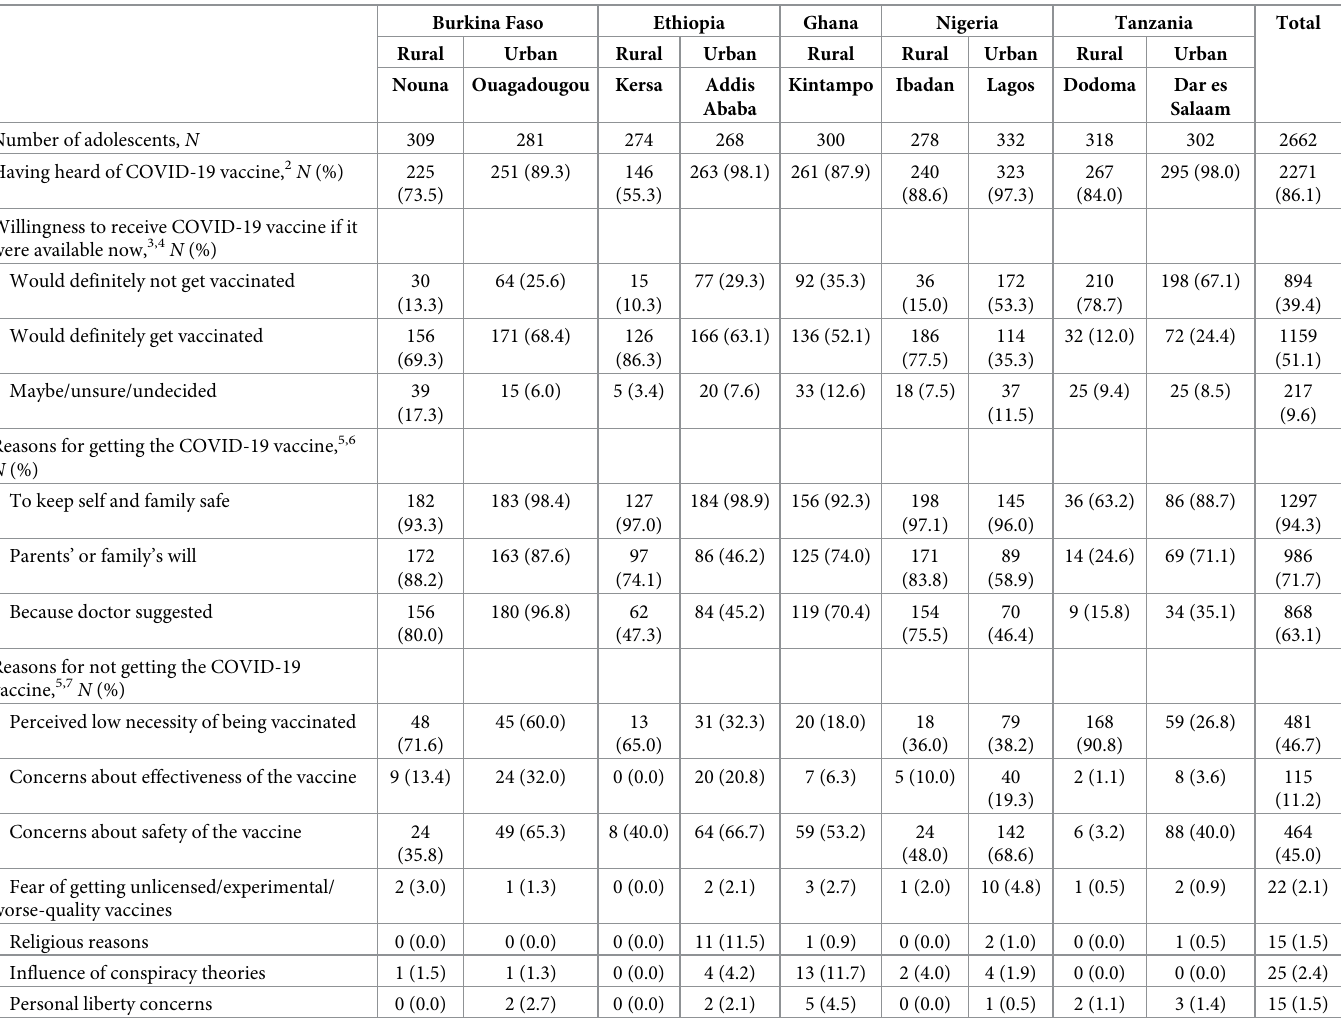
Table 2. Willingness to receive COVID-19 vaccines among adolescents in a phone-based survey in five sub-Saharan African countries, 2021 1